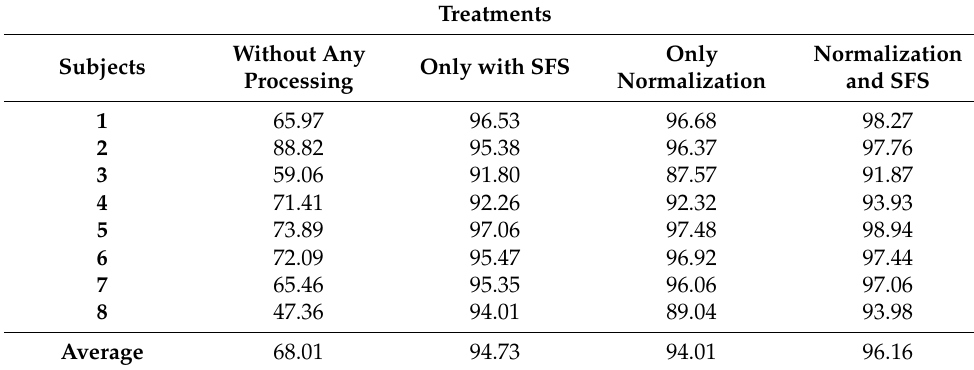
Table 9. Percentage of recognition for each treatment for each subject with QDA. Treatments Without Any Subjects Only with Processing